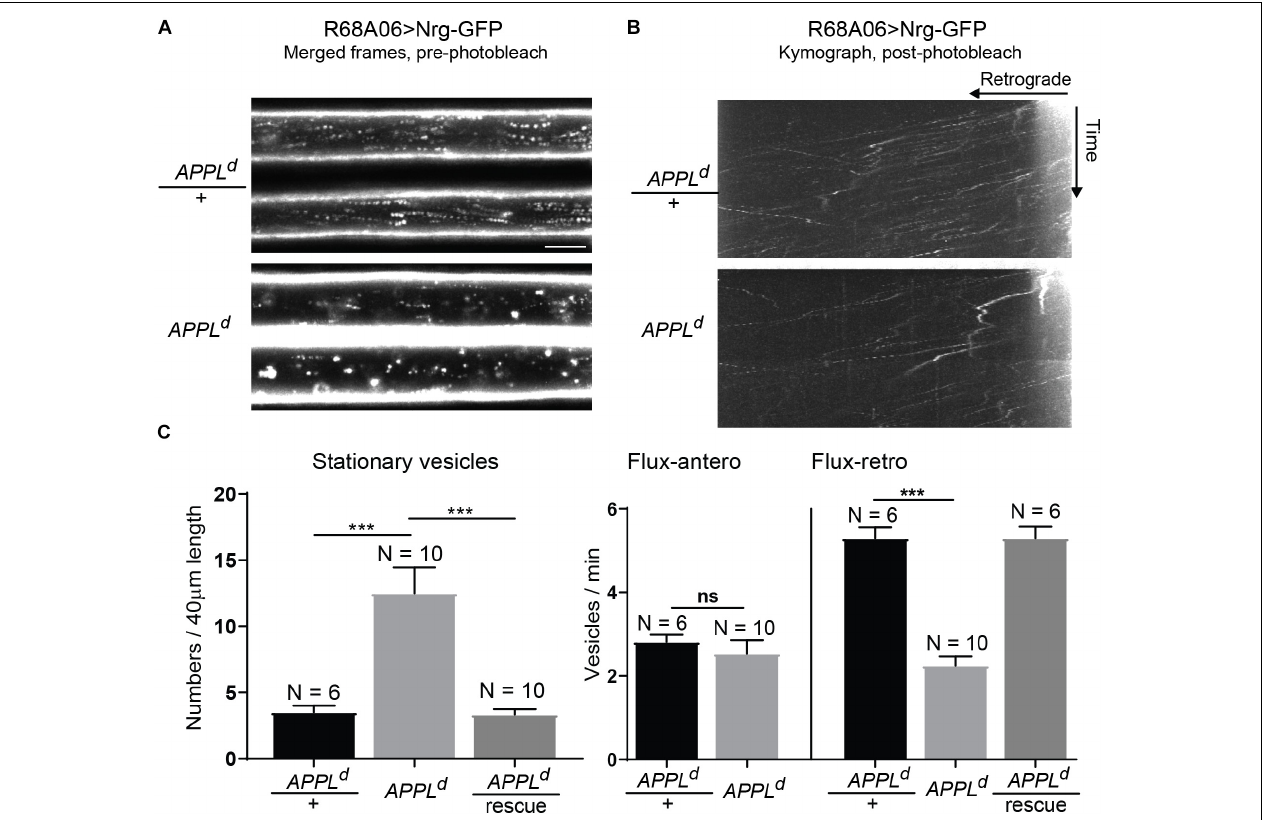
FIGURE 2 | Neuroglian axonal trafficking in APPL loss of function mutants. (A) Merged frames of live recordings without photobleaching ( Supplementary Videos S2, S3 ). Moving vesicles produce a “motion-streak,” which is more abundantly seen in wildtype animals than in APPL d null mutants. Videos were obtained at one frame per second. Scale bar represents 5 µ m. (B) Kymographs of axonal transport of Nrg-GFP vesicles in control animals ( APPL d /+) and APPL d mutants ( Supplementary Videos S4, S5 ). A small section of the GF axon was photobleached to reduce background from Nrg labeling at the axonal membrane, allowing the visualization of vesicles that enter the bleached region. Videos were obtained at one frame per second. (C) Quantification of Nrg-GFP vesicle trafficking in wildtype controls ( APPL d /+), APPL d as well as in APPL d rescue animals (UAS-Nrg-GFP co-expressed with UAS-APPL in APPL d background using R68A06 Gal4-line). Numbers of stationary vesicles, and numbers of vesicles moving in anterograde and retrograde direction (Flux) were analyzed. N indicates numbers of axons assessed. Error bars represents standard error mean. Statistical significance between genotypes was assessed using Student’s t -test ( ∗ p ≤ 0.05, ∗∗ p < 0.01, ∗∗∗ p < 0.001, ns – non-significant, p >